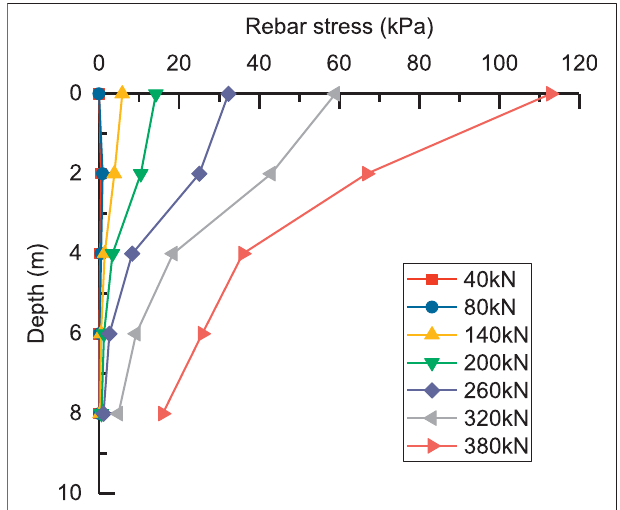
FIGURE 3 | Stress variation in the steel rebar of TSP2 under static load test.